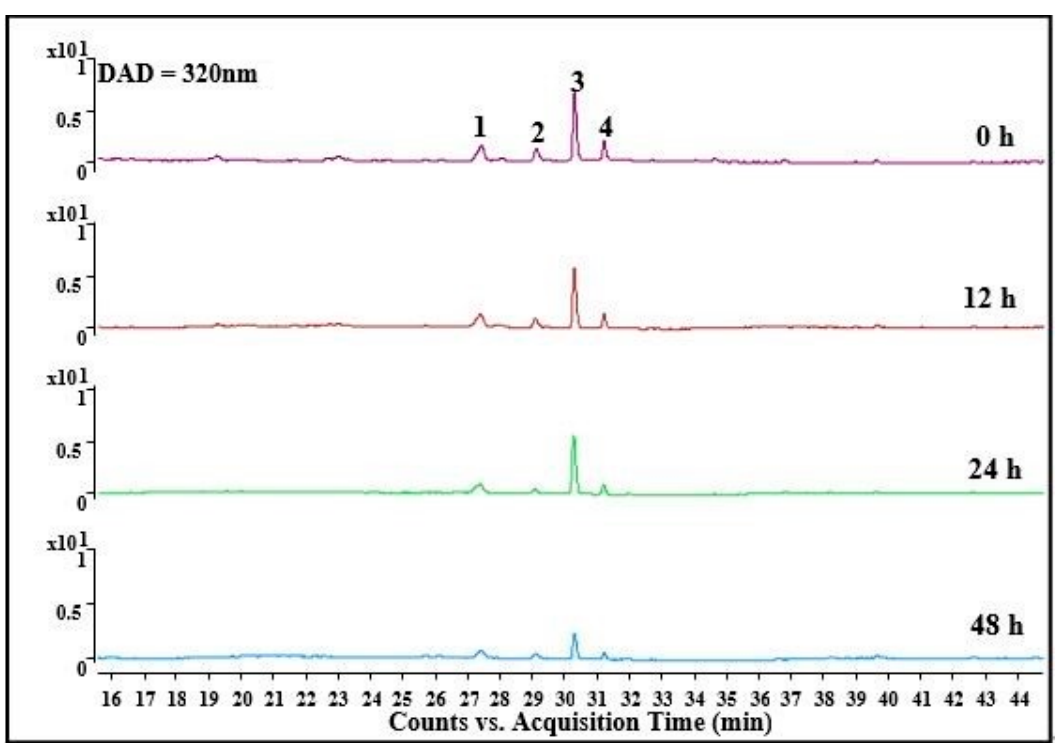
Figure 2. The change of the major phenolics in THR extract during colonic fermentation by human microflora.